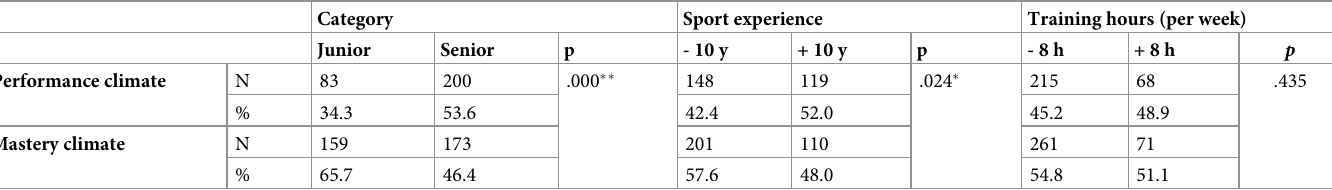
Table 4. Profile’s characteristics based on game category, sport experience and training